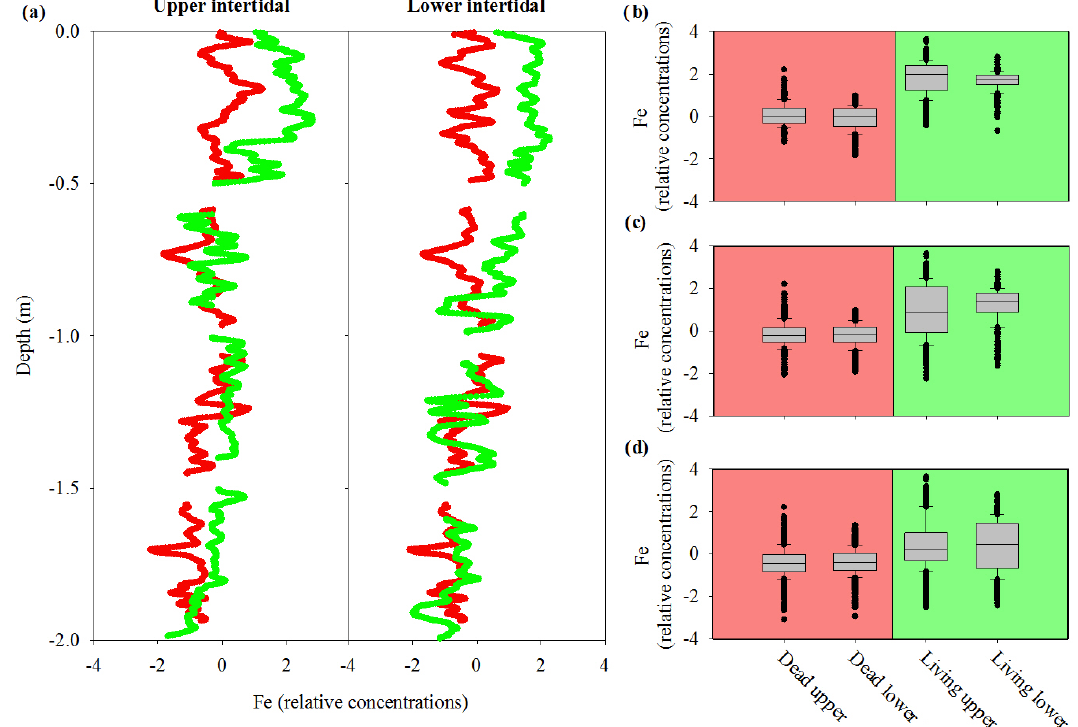
Figure 5. (a) Fe relative concentrations in sediment cores to 2m depth from the upper and lower intertidal areas of living (green) and dead (red) mangroves in the Gulf of Carpentaria, based on Itrax analysis. Box plots of normalized Fe relative concentrations from sediment cores to depths of (b) 0.5m, (c) 1m and (d) 2m. The central horizontal line represents the median value, the box represents the upper and lower quartiles, and the whiskers represent the maximum and minimum values excluding outliers, i.e. the black dots.